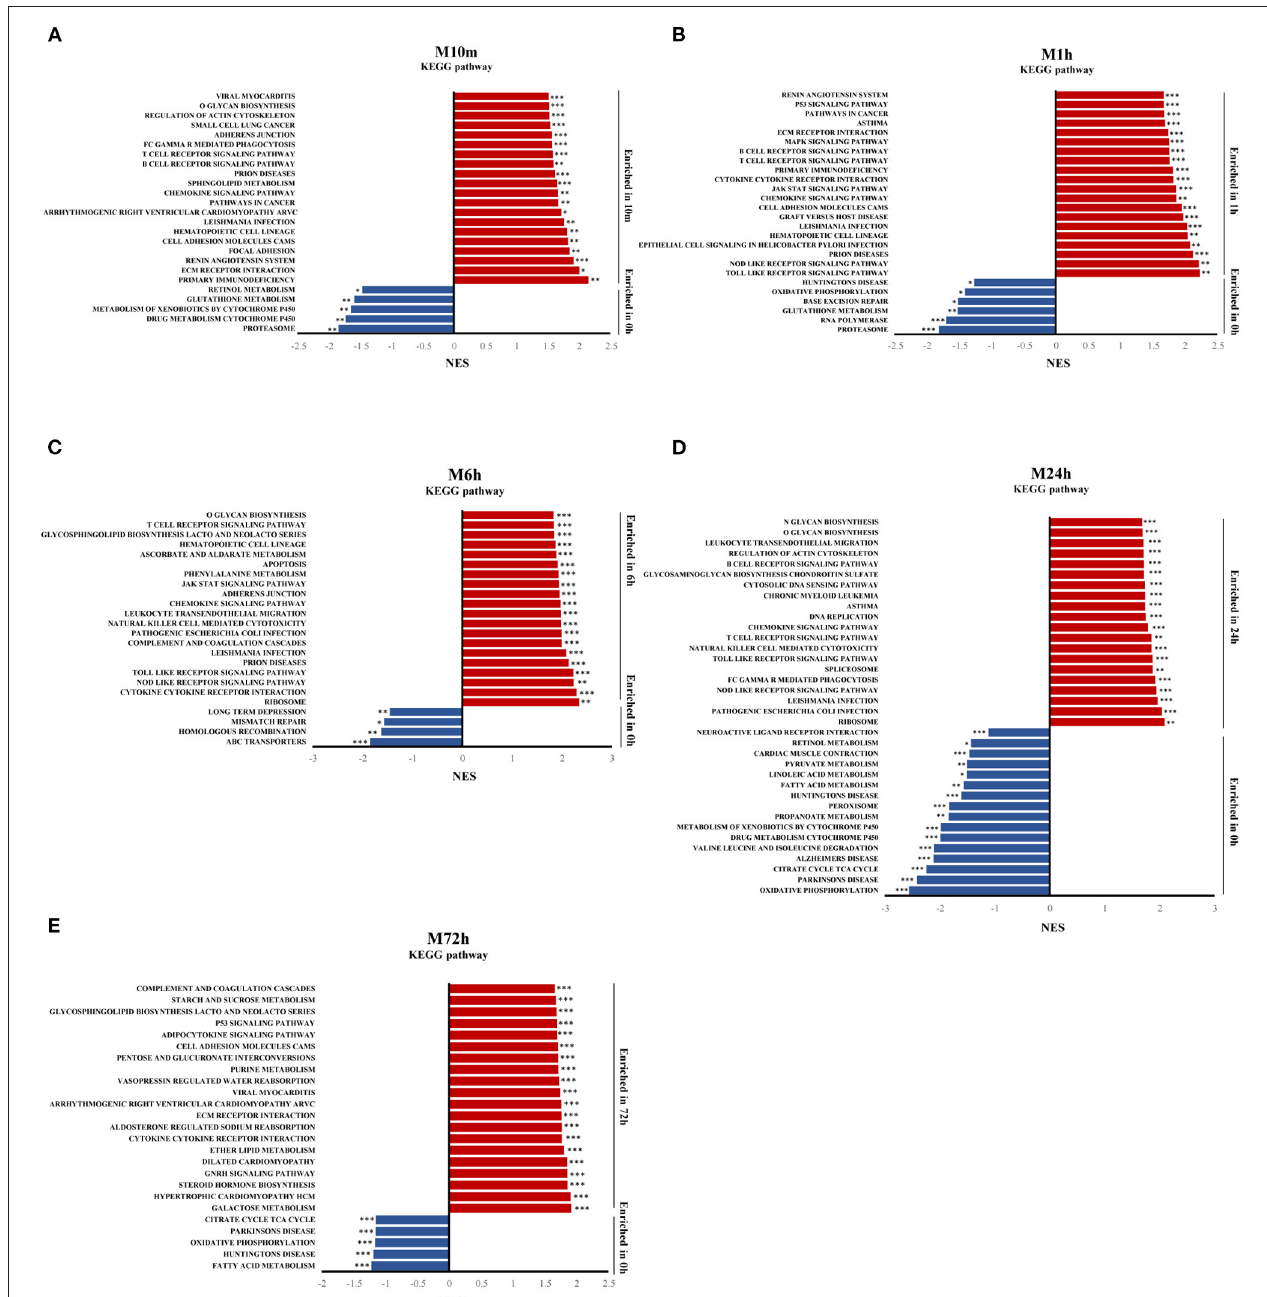
FIGURE 3 | Gene expression analysis by GSEA. (A–E) Gene set enrichment analysis (GSEA) of KEGG gene sets from the Molecular Signatures Database (MSigDB), showing the most significantly enriched gene sets in MI, and their normalized enrichment scores. * p -value < 0.05, ** p -value < 0.01, *** p -value <